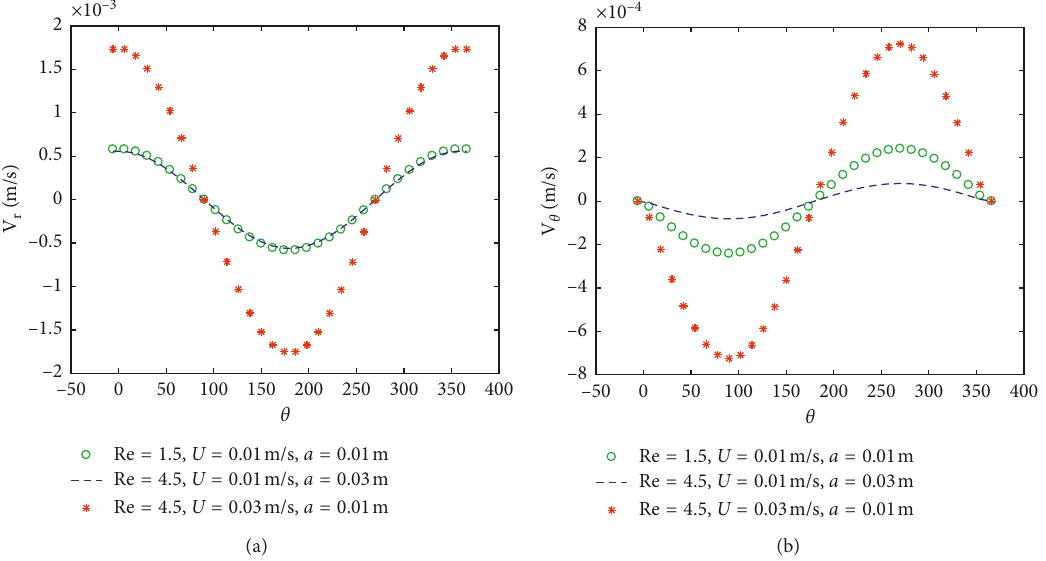
Figure 10: Angular distribution of velocity under different Reynolds number at r � 1 . 55 a and t � 350 μ s . (a) Radial velocity. (b) Cir- cumferential